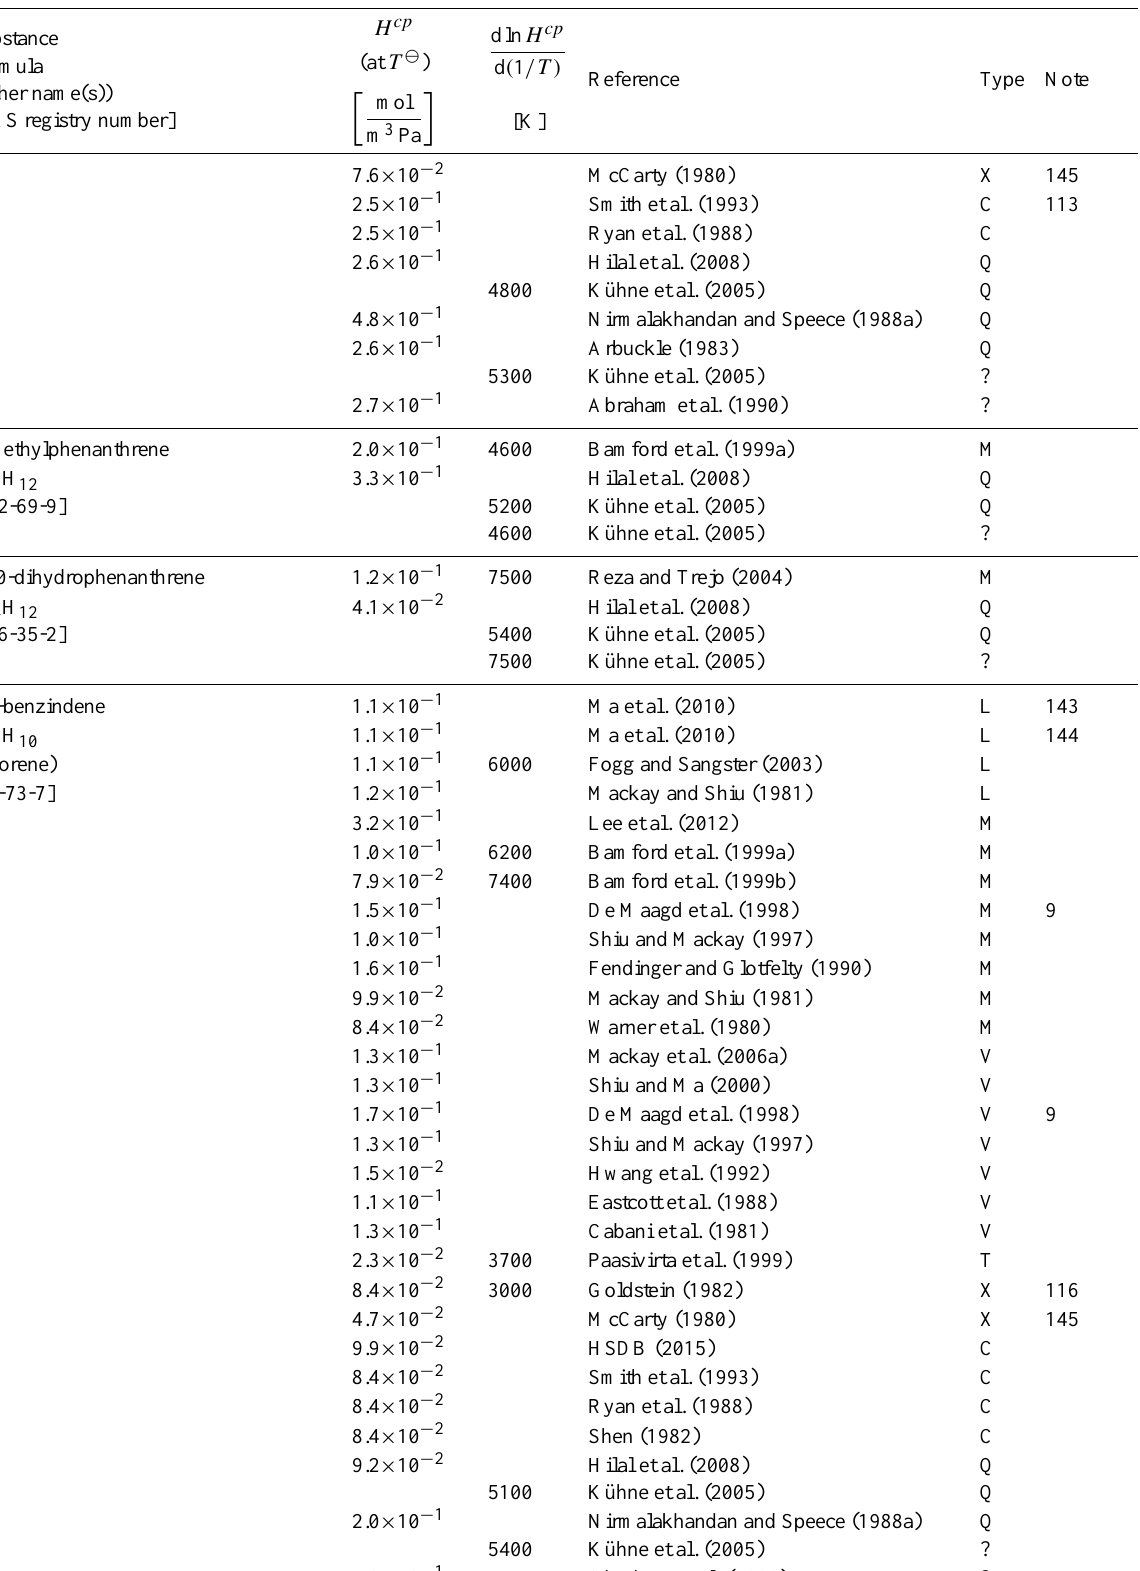
Table 6: Henry’s law constants for water as solvent